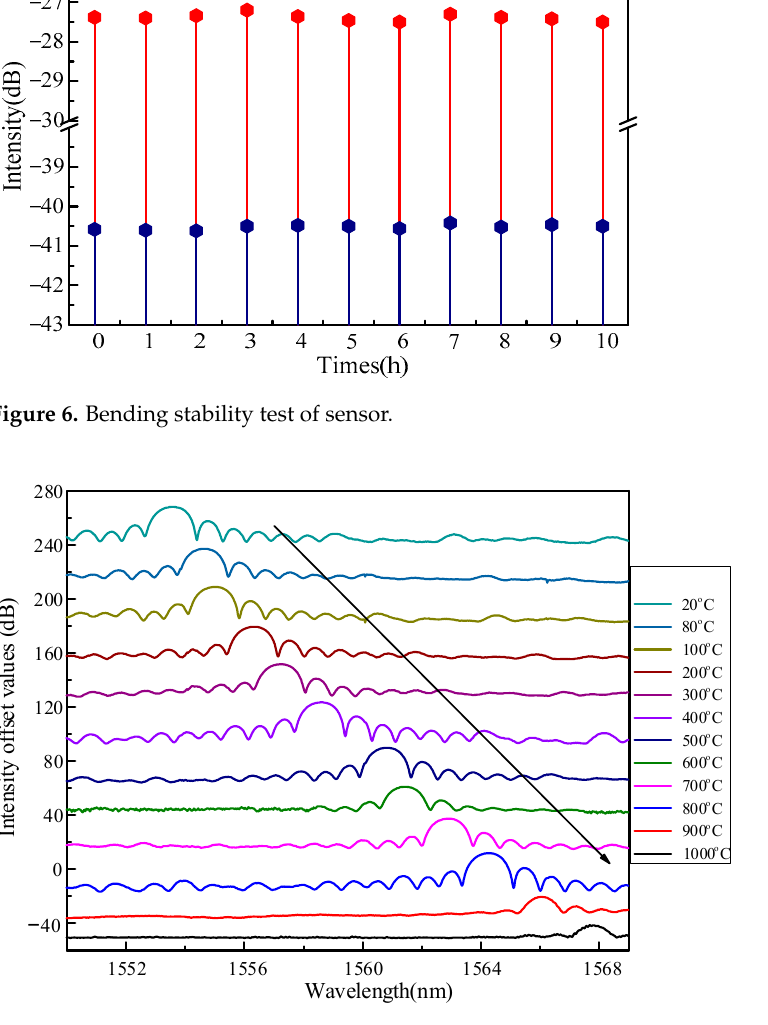
Figure 6. Bending stability test of sensor.